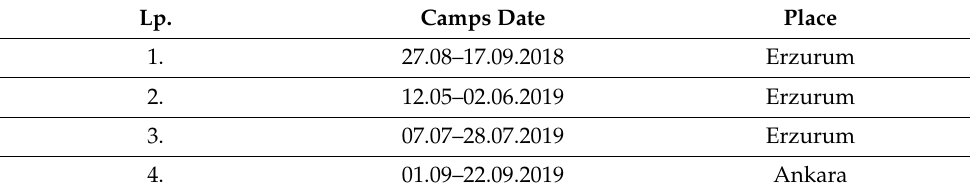
Table 1. Schedule of training camps in high altitude conditions planned for the athlete (M.W.). Lp.